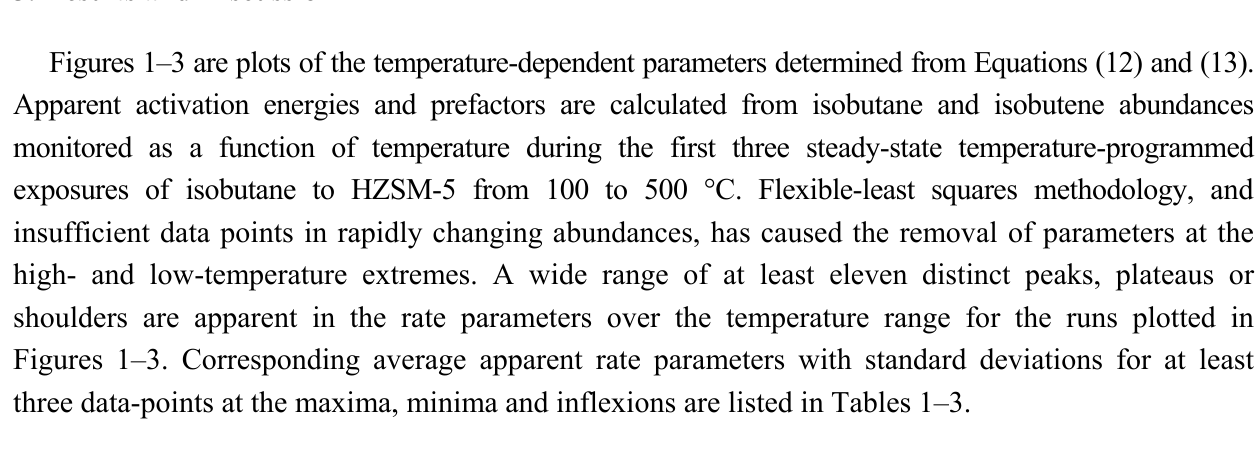
Figure 1. Apparent activation energies (blue circles) and prefactors (red circles) for the first temperature-programmed run for isobutene evolution over